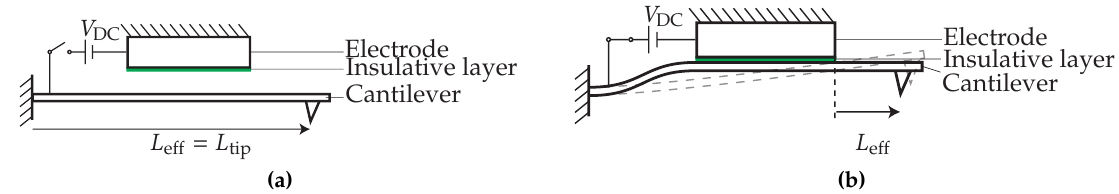
Figure 2. In ( a ) the cantilever is in unadjusted state. When the bias voltage V DC is applied, the cantilever will start bending towards the electrode; When the bias voltage is bigger than the pull-in voltage, the cantilever will pull-in towards the electrode ( b ). The cantilever will hit the electrode (dashed line) and will be in a stable state. When the voltage is further increased, the cantilever will finally be in the adjusted state. The effective length L eff of the cantilever has decreased, and the stiffness is increased.